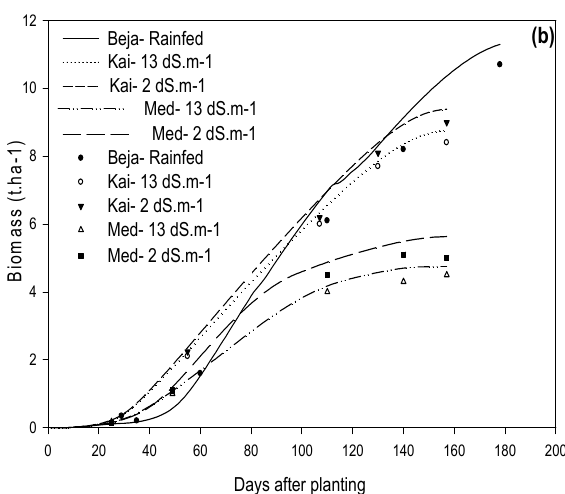
Figure 3. Simulated and observed biomass of ( a ) tolerant and ( b ) sensitive barley genotypes (dots represent observations; simulations are represented by lines).